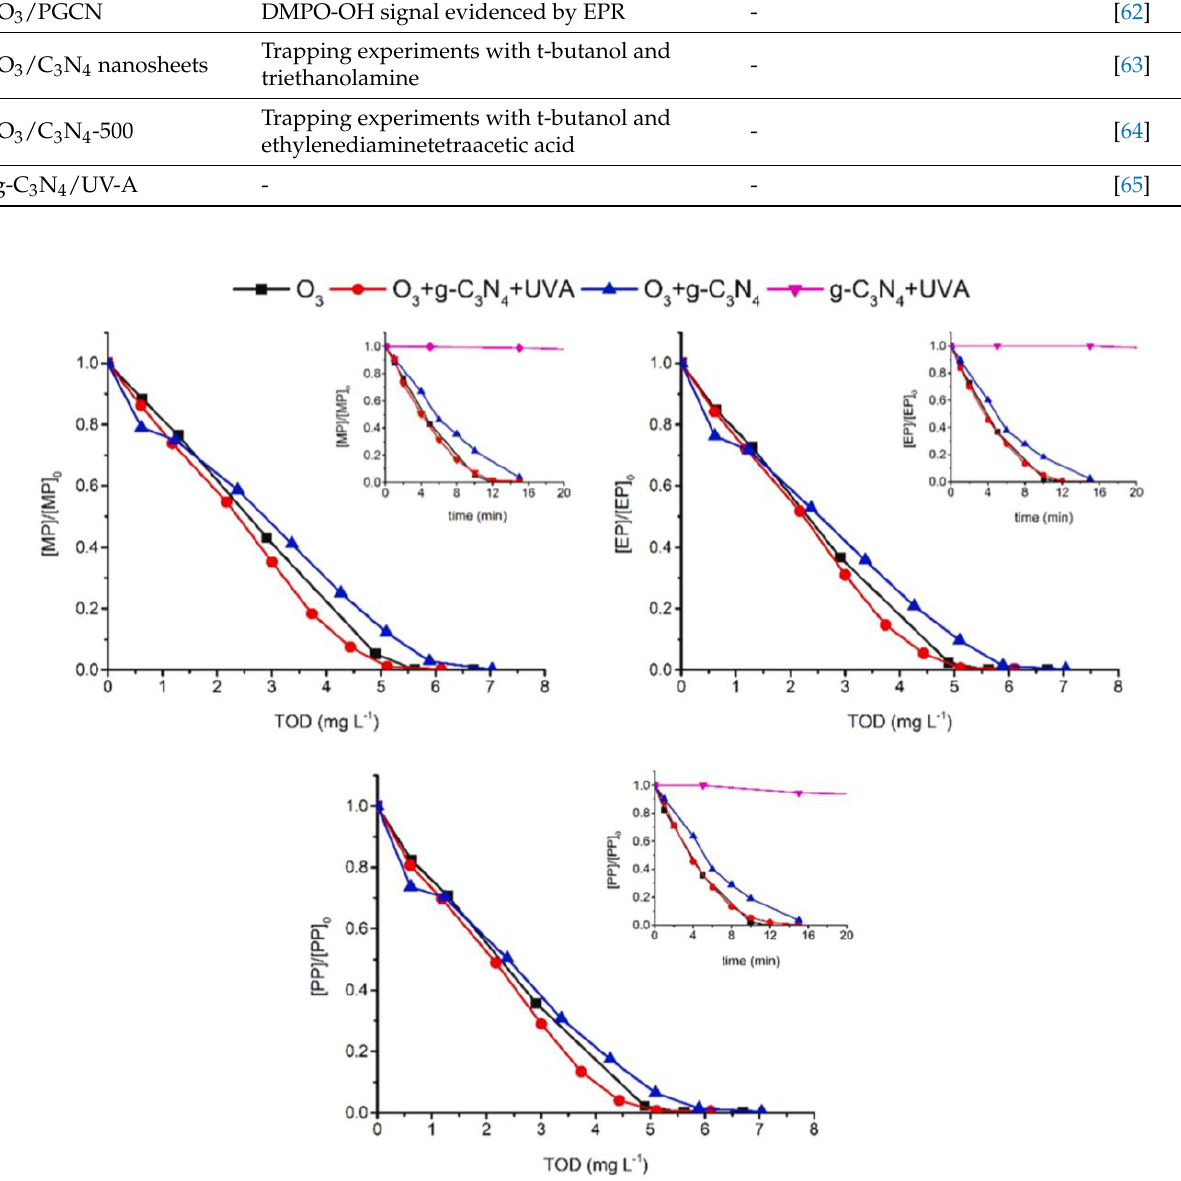
Table 1. Summary of the of detection of • OH radicals and their quantification by g-C 3 N 4 catalysts under visible-light irradiation with O 3 .